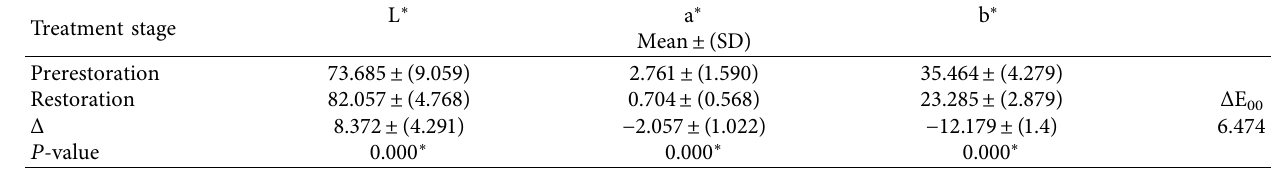
∗ indicates a significant difference between tooth structure and restoration values. Table 3: Color difference in L ∗ , a ∗ , and b ∗ at restoration and after bleaching measurements. Treatment stage Restoration